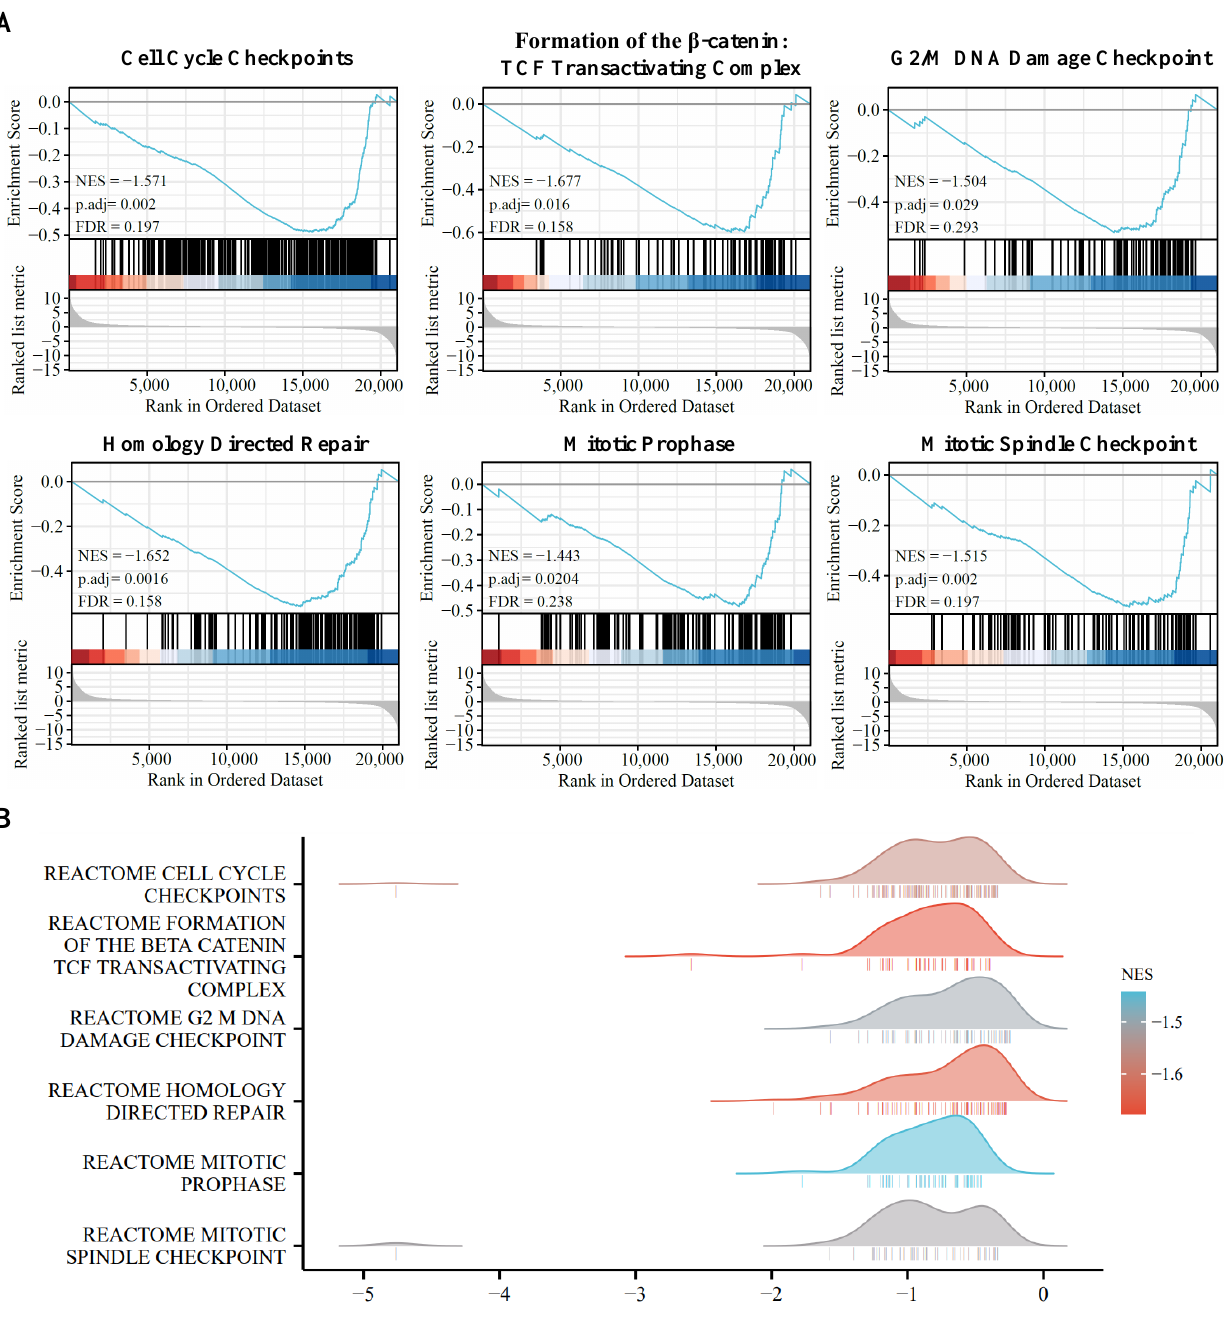
Figure 4. Pathway enrichment analysis of the DE-mRNAs. ( A ) Gene set enrichment analysis (GSEA) displays the top 6 enriched pathways in DE-mRNAs. ( B ) Ridge plots with normalized enrichment score (NES) display these most enriched pathways in DE-mRNAs in